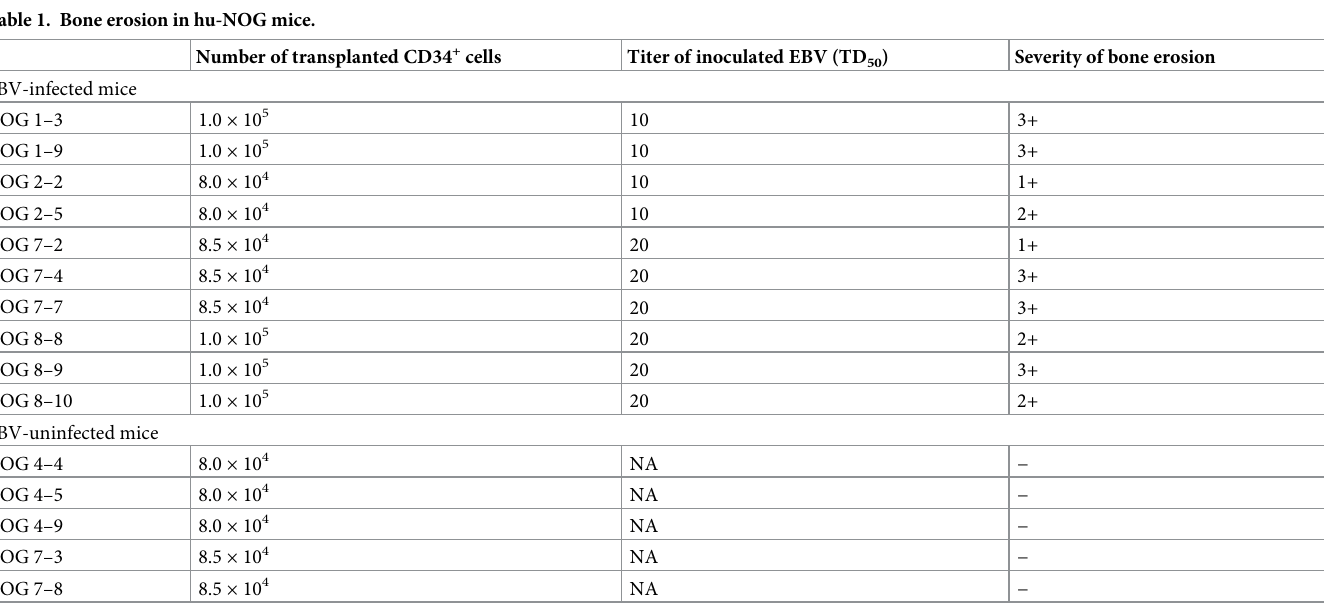
Table 1. Bone erosion in hu-NOG mice. Number of transplanted CD34 + cells Titer of inoculated EBV (TD 50 ) Severity of bone erosion EBV-infected